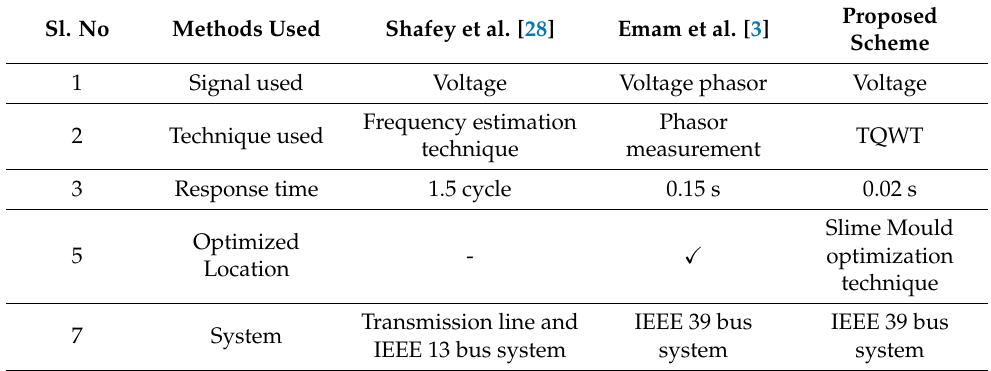
Table 4. Comparative